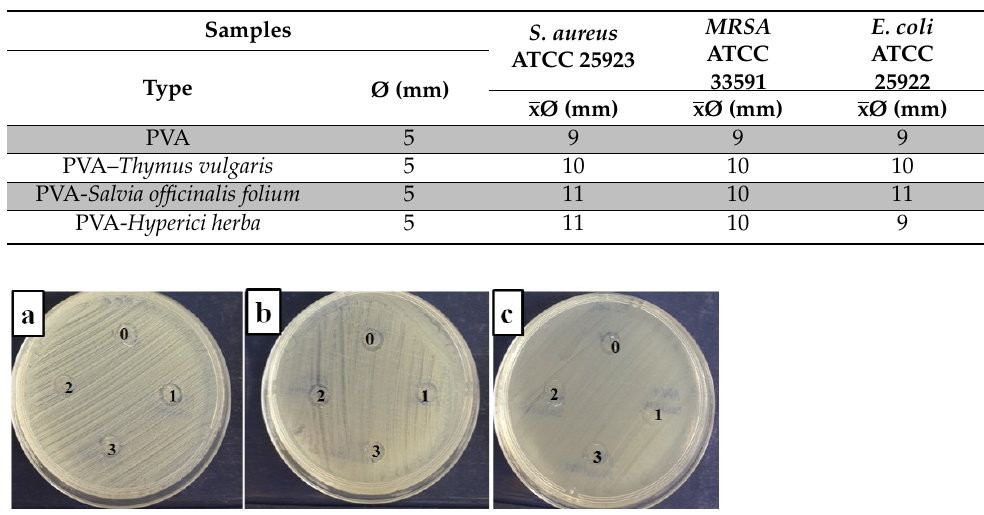
Table 2. The antibacterial activity of PVA fibers and PVA fibers–plant extract system nanofibers against S. aureus, MRSA , and E. coli.